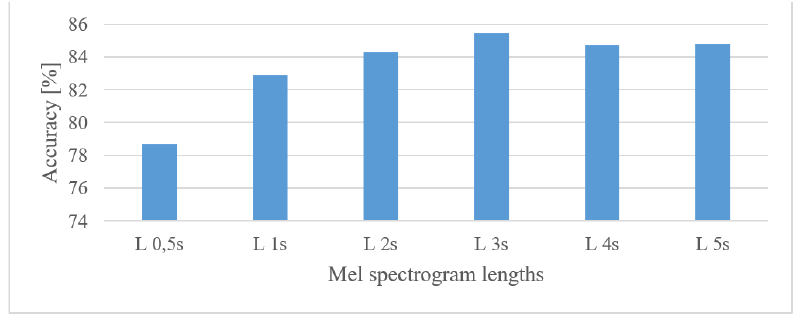
Figure 6. Accuracies of the measured lengths (L) of 100 Hz–10 kHz MFBs.